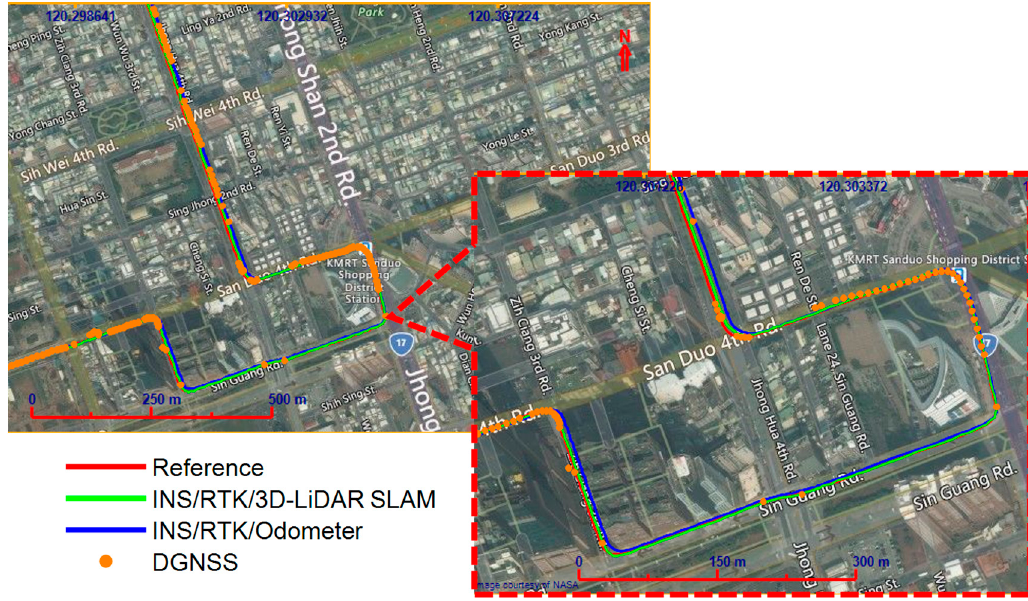
Figure 12. Scenario 1: zoomed GNSS-denied area.